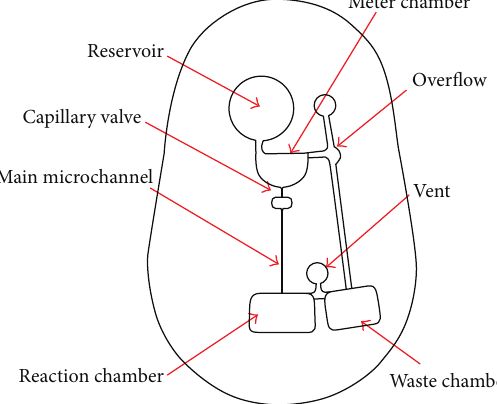
Figure 1: Design of radial microfluidic chip.